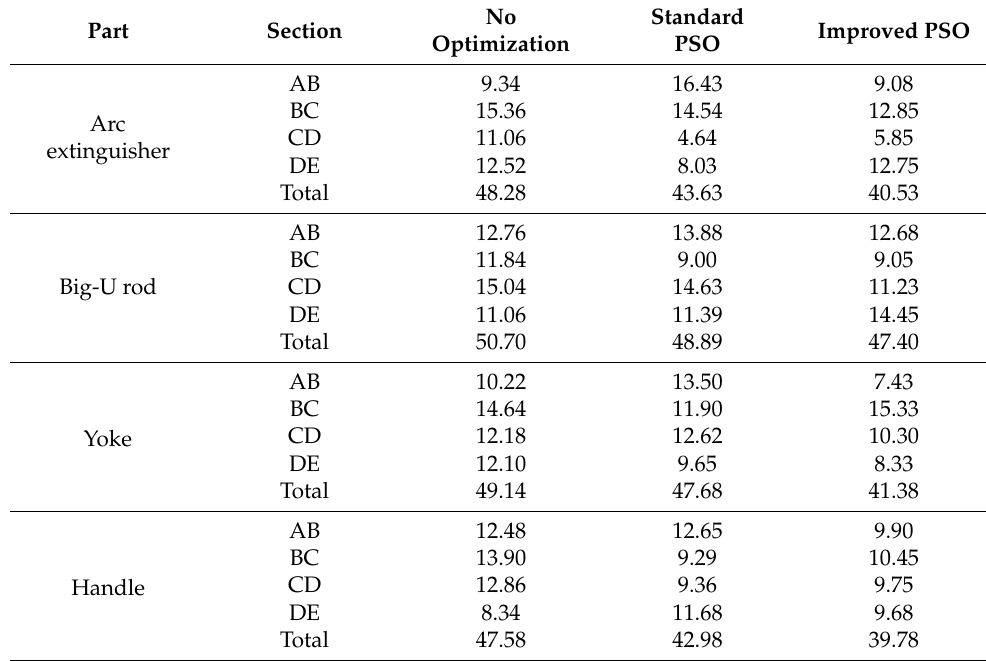
Table 7. Comparison of operating times of different parts on the experimental platform (unit: s).